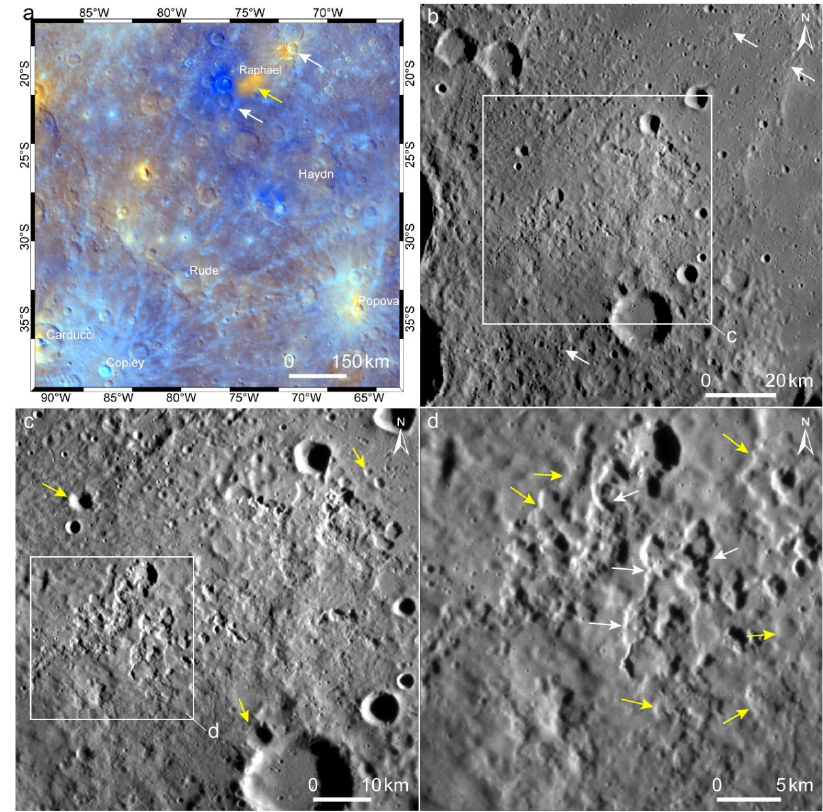
Figure 7. A young pitted-ground volcano in the floor of the Raphael crater (D = 342 km; central coordinates are 20.4°S, 283.7°E). ( a ) Color mosaic shows a patch of reddish pyroclastic deposits (yellow arrow) on the southern floor of the Raphael crater. The two white arrows point to impact rays that are formed by the Copley and an unnamed crater. ( b ) Secondaries in impact rays (white arrows) are not visible in the pitted-ground volcano. ( c ) The pits have well-preserved topography, and they are in sharp contrast with the background impact craters (yellow arrows). ( d ) The pits have slightly different preservation states (yellow and white arrows). IDs of the base data used are listed in Table